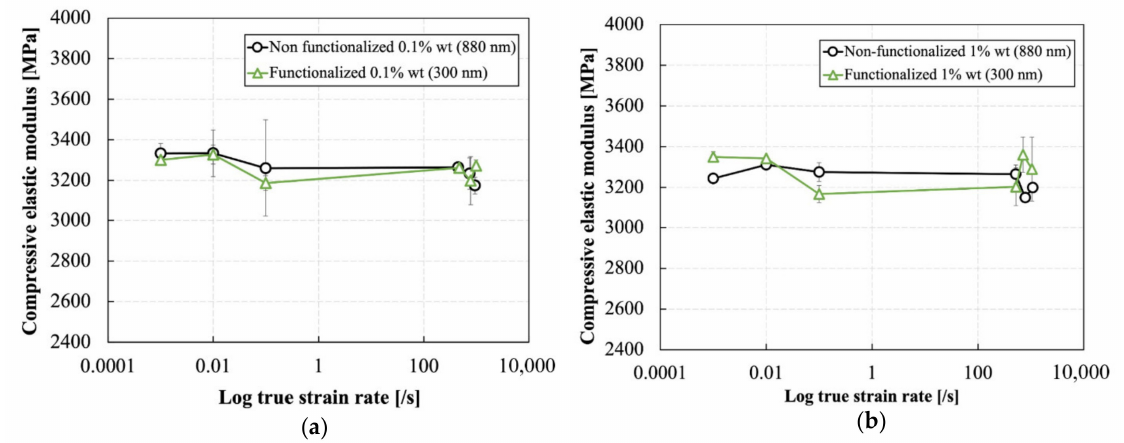
Figure 13. Effect of silica nanoparticles size and surface functionalization on the compressive elastic modulus for the silica nanoparticle-filled epoxy at different particle weight contents: ( a ) 0.1% and ( b )